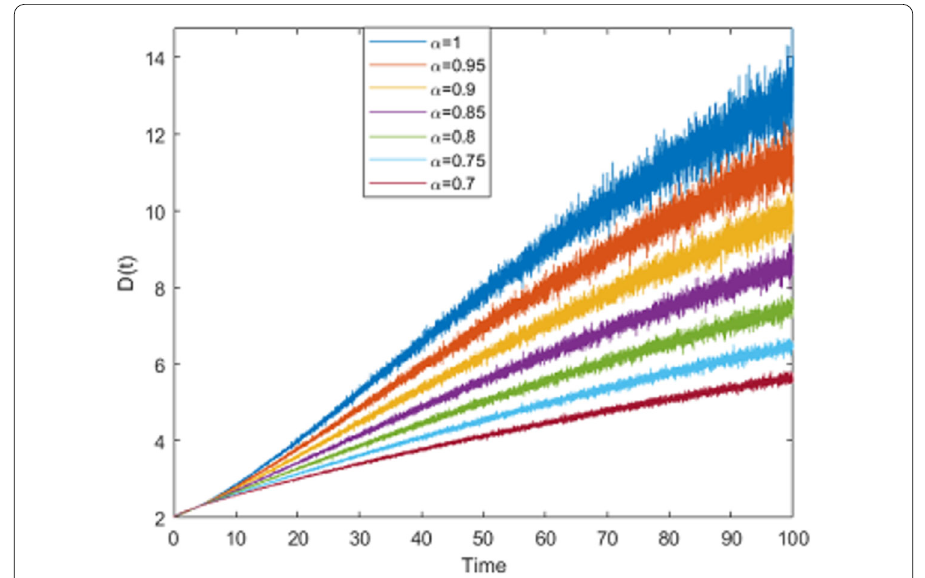
Figure 19 The class of researchers that die, retire, or leave fractional calculus for σ 6 = 0.00062